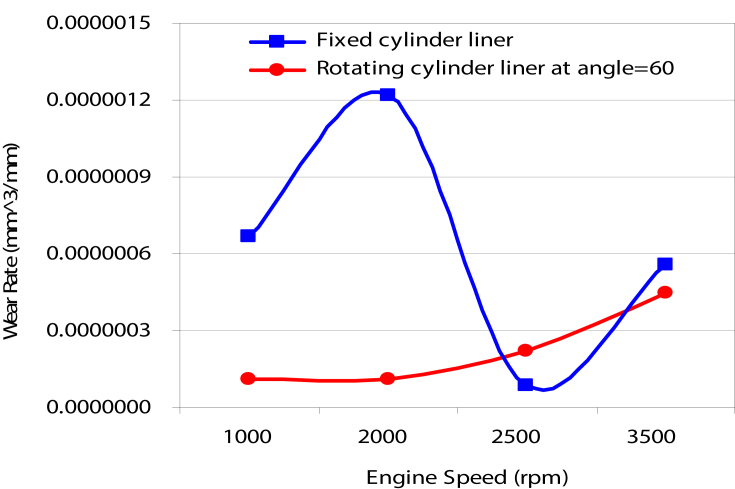
Wear rate of cylinder liner (fixed cylinder liner, rotating cylinder liner positioned at 60oangle.